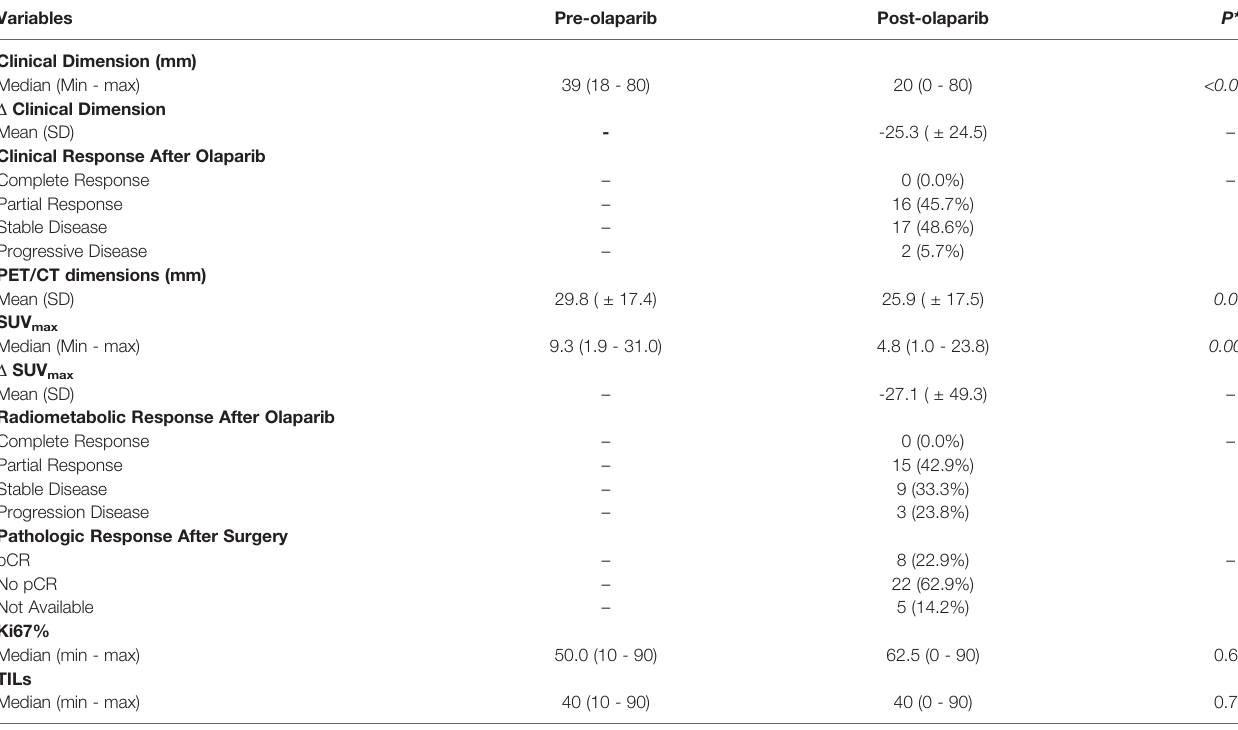
TABLE 2 | Clinical and radiometabolic responses, pathologic and immunologic changes induced in the overall population by olaparib.